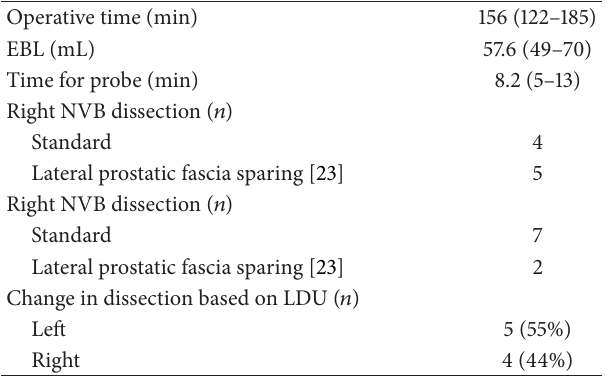
Table 2: Intraoperative data.